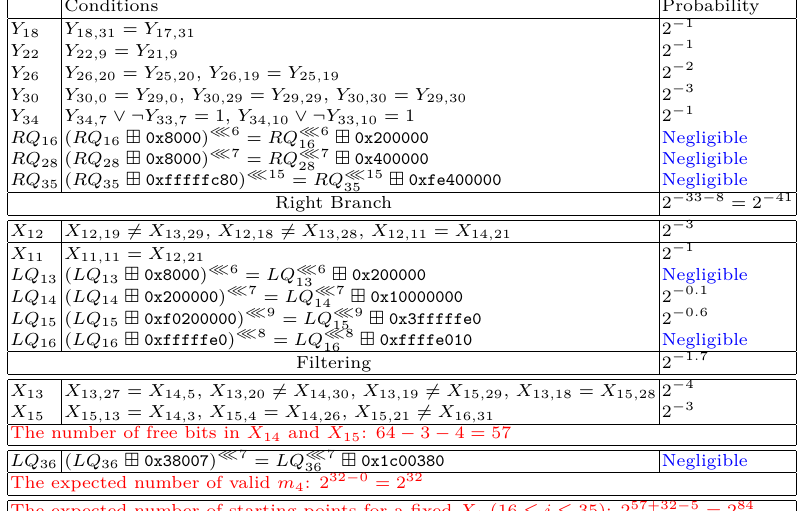
Table 6: Other conditions influencing the attack for the 36-step differential characteristic Conditions Probability Y